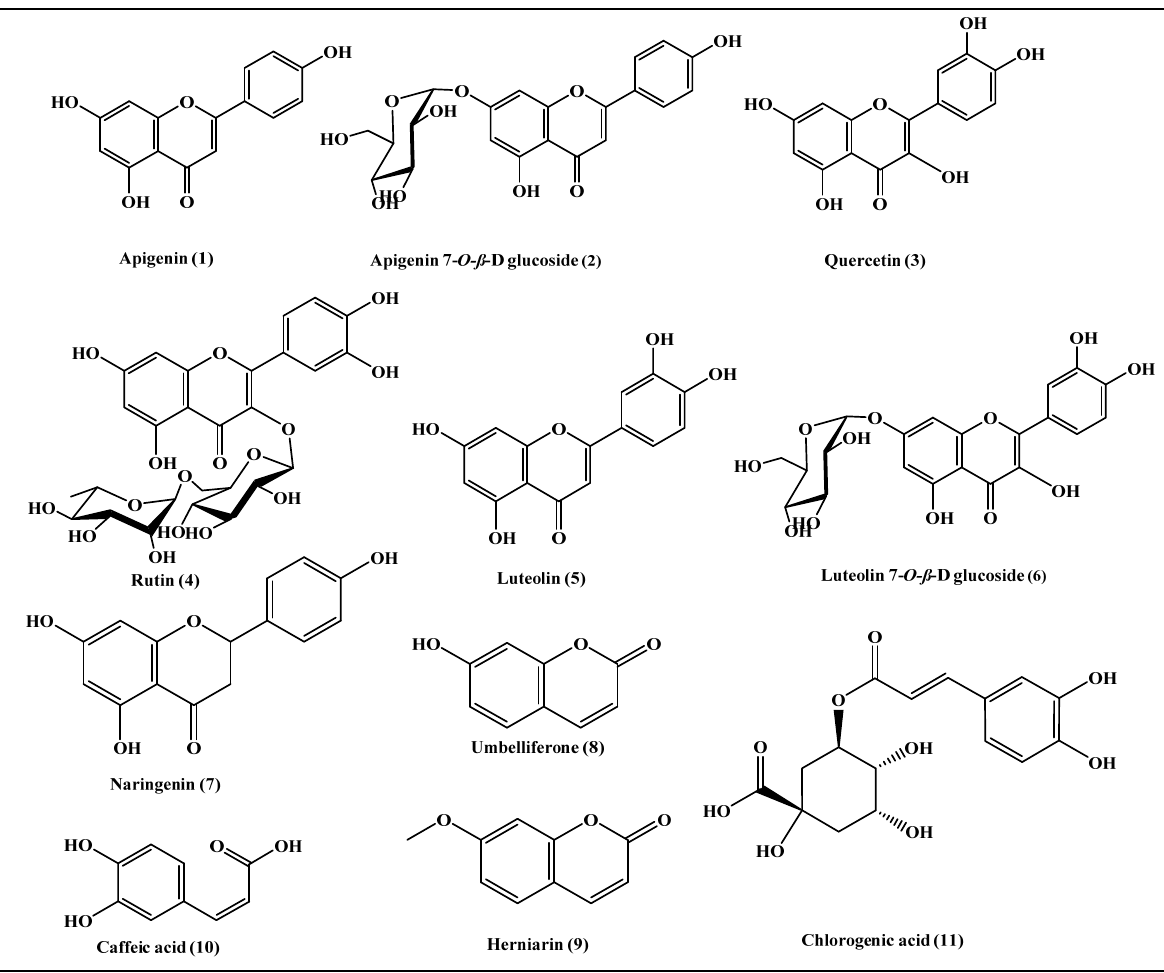
Figure 4. Scheme showing the chemical structures of phenolic bioactive compounds previously identified from Matricaria chamomilla flowers.